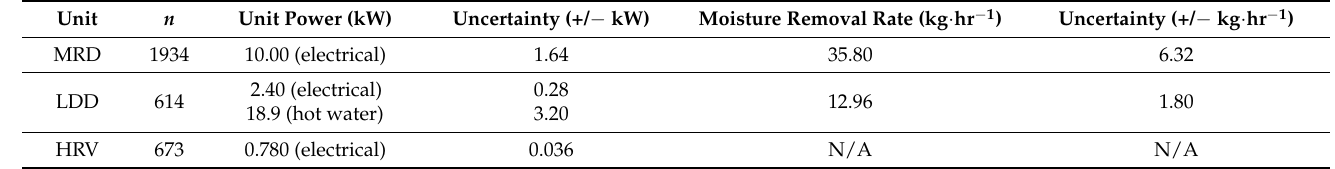
Table 4. Summary of dehumidification units ( n is number of data points